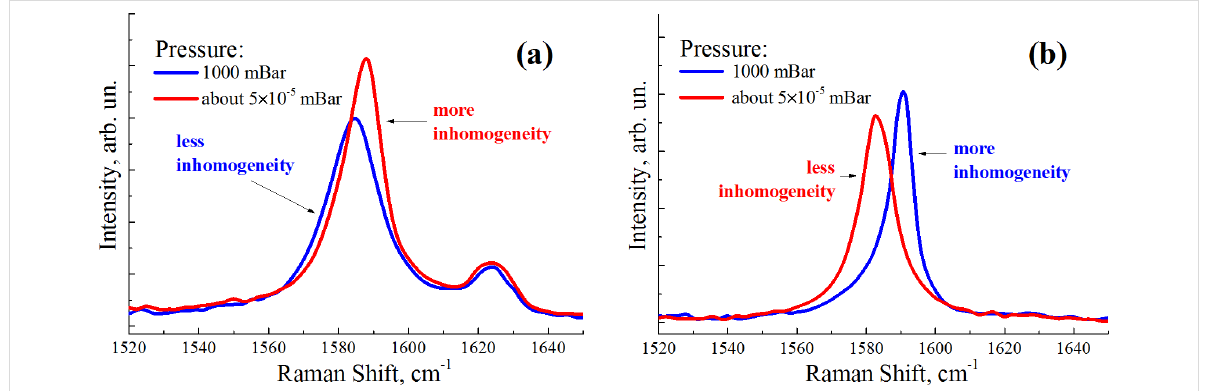
Figure 3: G peak profile for (a) nitrogen-doped graphene on SiO 2 /Si and (b) graphene on Al 2 O 3 at normal and reduced pressures.